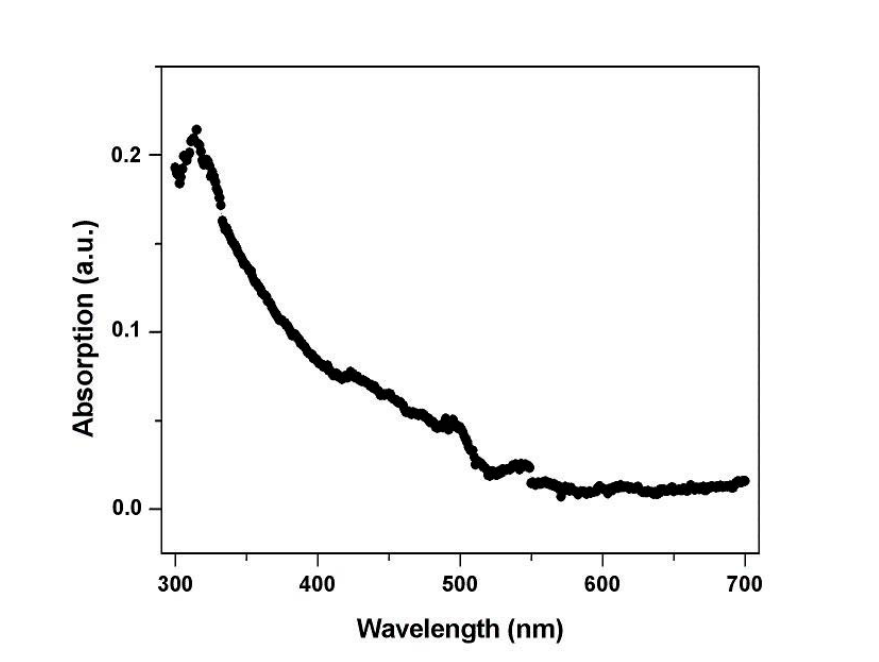
Figure 10. Absorption spectrum obtained for sample 1 with LDR